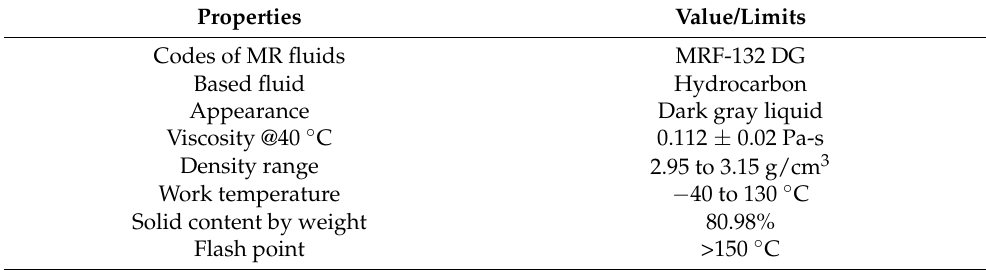
Table 1. Characteristics of MRF-132 DG